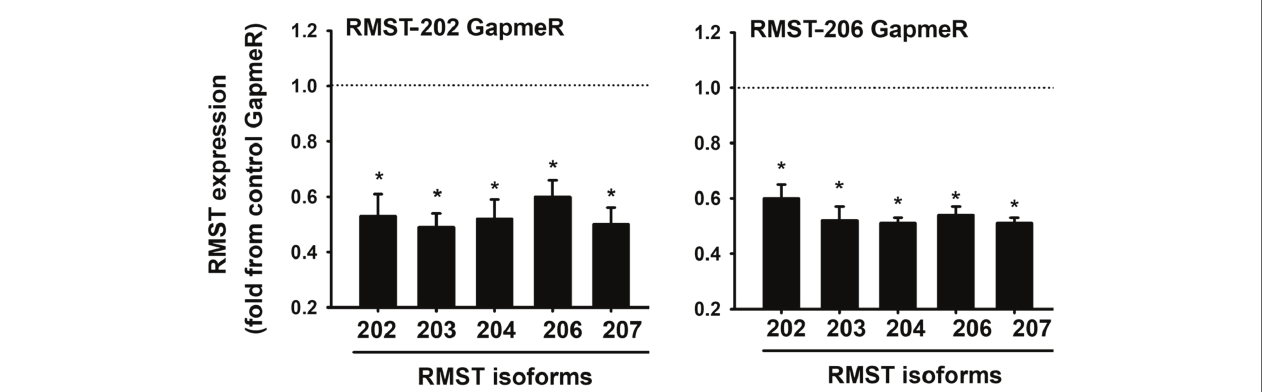
FIGURE 2 | LNA GapmeR knockdown of RMST in HUVECs. mRNA expressions of 5 RMST isoforms in HUVECs 48 h post-transfection with 12.5 nM of scrambled (control) GapmeR, 12.5 nM of RMST-202 GapmeR ( left ), or 6.25 nM of RMST-206 GapmeR ( right ). Values are means ± SEM, expressed as fold from control GapmeR. * p < 0.05, compared to control GapmeR. N = 8.